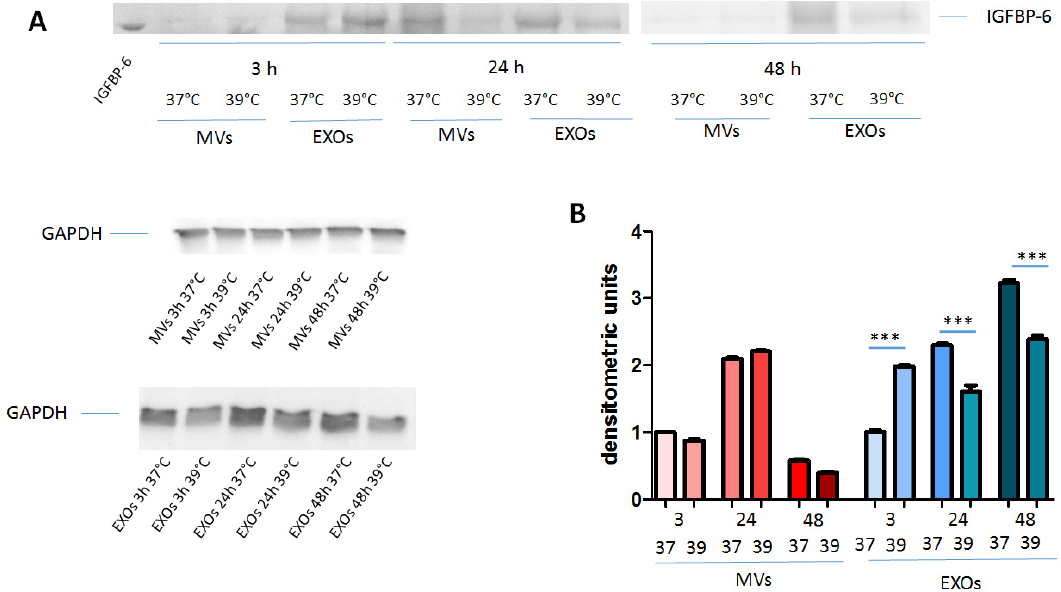
Figure 1. Microvesicles (MVs) and exosomes (EXOs) derived from monocyte-derived dendritic cells (Mo-DCs) contain IGFBP-6. Mo-DCs were incubated at either 37 °C or 39 °C for 3 h, 24 h, or 48 h, and at each time point, MVs and EXOs were isolated from the conditioned medium. ( A ) Western blotting of IGFBP-6 and GAPDH. Purified IGFBP-6 (0.2 μ g) was loaded as positive control. ( B ) Densitometric analysis of IGFBP-6 normalized to GAPDH. Intensity of MVs and EXOs IGFBP-6 at 37 °C for 3 h was put to 1 as reference. The results are shown as mean ± SD of two experiments. *** p < 0.0001.